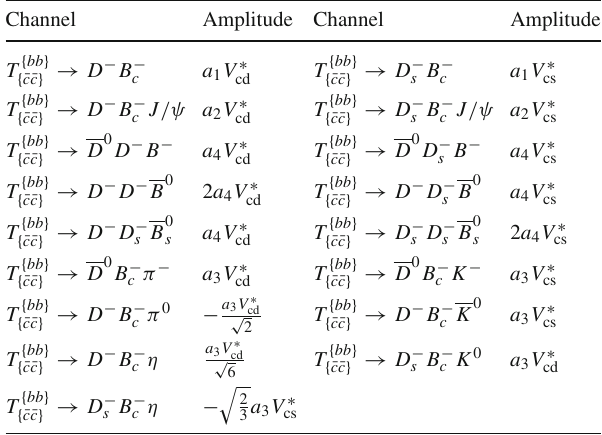
{ bb } Table 2 Tetraquark T {¯ c ¯ c } decays into two and three mesons for the transition b → c ¯ cd / s Channel Amplitude Channel